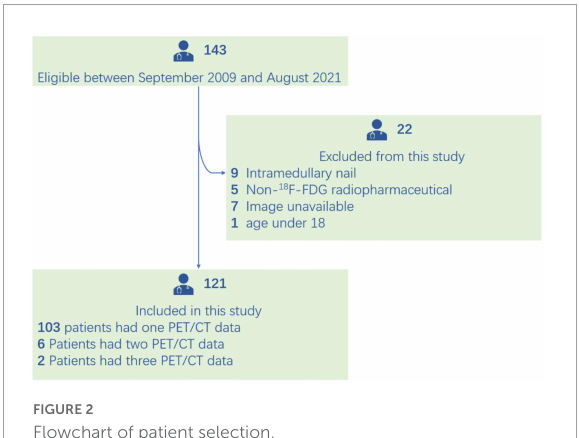
FIGURE2 Flowchart of patient selection.